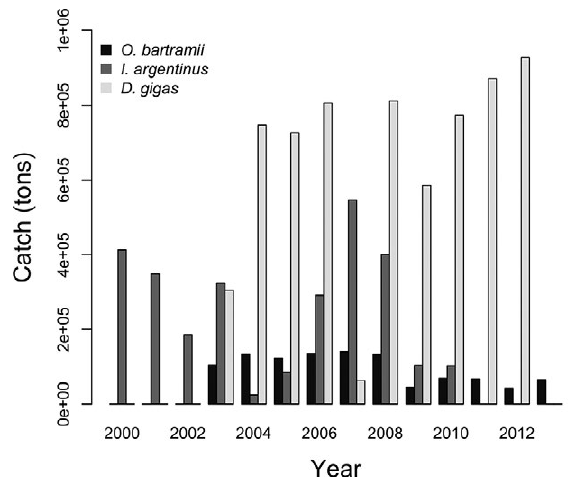
Fig. 1. – Annual catch for O. bartramii in the northwest Pacific, I. argentinus in Southwest Atlantic and D. gigas in the southeast Pacific.